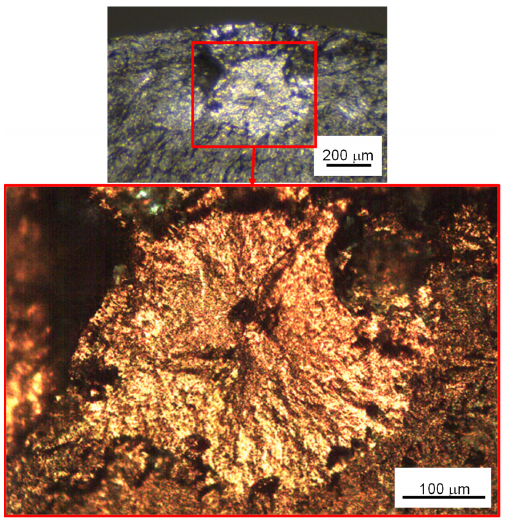
Machines 2023 , 11 , x FOR PEER REVIEW Figure 9. Crack initiation site in a sample of Set HMP-M. Figure 9. Crack initiation site in a sample of Set HMP-M.